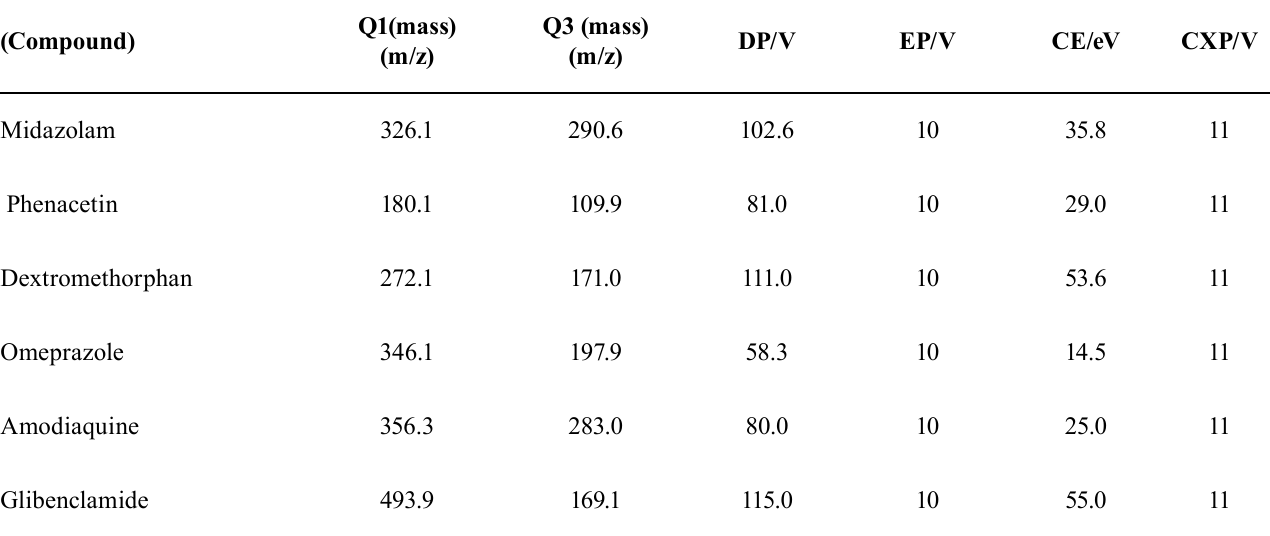
TABLE I – M RM transitions and collision energy and for the detection of the CYP probe drugs and internal standard